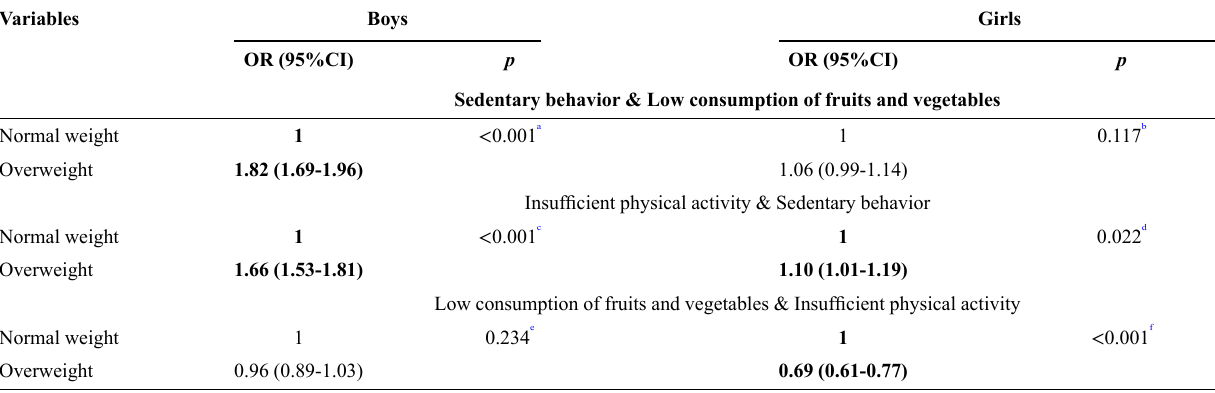
Table 5 - Association between BMI and pairs of specific combinations of obesogenic risk factors, sex-stratified ACtVU Study. Uberaba, Brazil